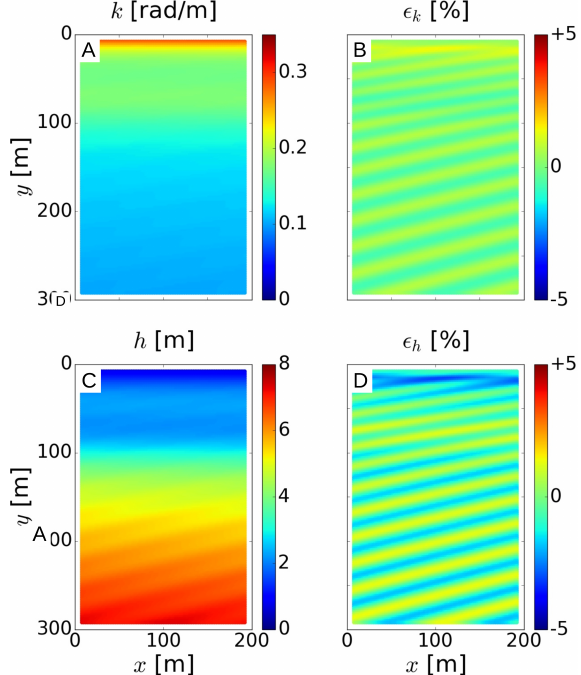
Figure 8. Recovered k ( A ) and h ( C ) and the corresponding local relative errors, (cid:101) k and (cid:101) h ( B , D , in %), obtained using the phase fitting method for the first EOF corresponding to linear propagation of W1 and for ∆ t = 0.5 s, ∆ x = 2 m, R t = 1 s, and R x = 8 m.